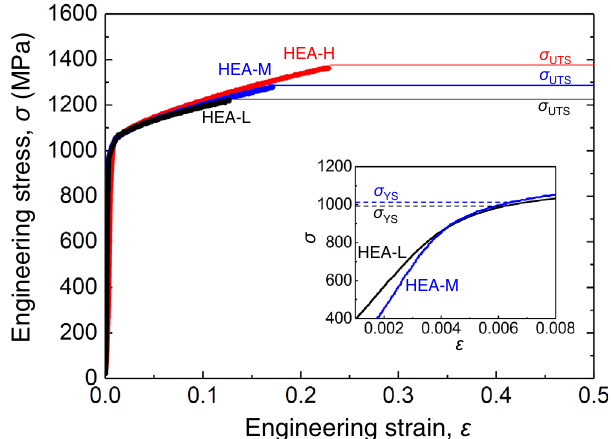
Fig.2|Tensilestress – straincurvesoftheB-dopedFe 40 Mn 40 Co 10 Cr 10 (at%)HEA at77Kfordifferentstrainrates. Thematerialwas fi nallyagedat773Kfor360min followedbyfurnacecoolingtoroomtemperature.Thisfccsingle-phasesamplewas tensile-testedat77K,withstrainrate έ =2.8×10 − 5 s − 1 (blackcurve;lowrate;labelled asHEA-L)and έ =1.1×10 − 4 s − 1 (bluecurve;moderaterate;labelledasHEA-M),under uniaxial quasistatic conditions. In addition, the tensile curve of the same alloy composition subjected to recrystallising at 1073K for 60min followed by water quenching to room temperature is included, along with the uniaxial quasistatic 77 K-straining curve at έ = 1.2×10 − 3 (red curve; high rate; labelled as HEA-H) for comparison 35 . All samples exhibited similar grain sizes ranging from ~3.5 – 5.1 μ m. ε σ σ YS represents the 0.2% offset yield strength; f , the total elongation; and UTS , the maximum tensile strength. Inset: the magni fi ed